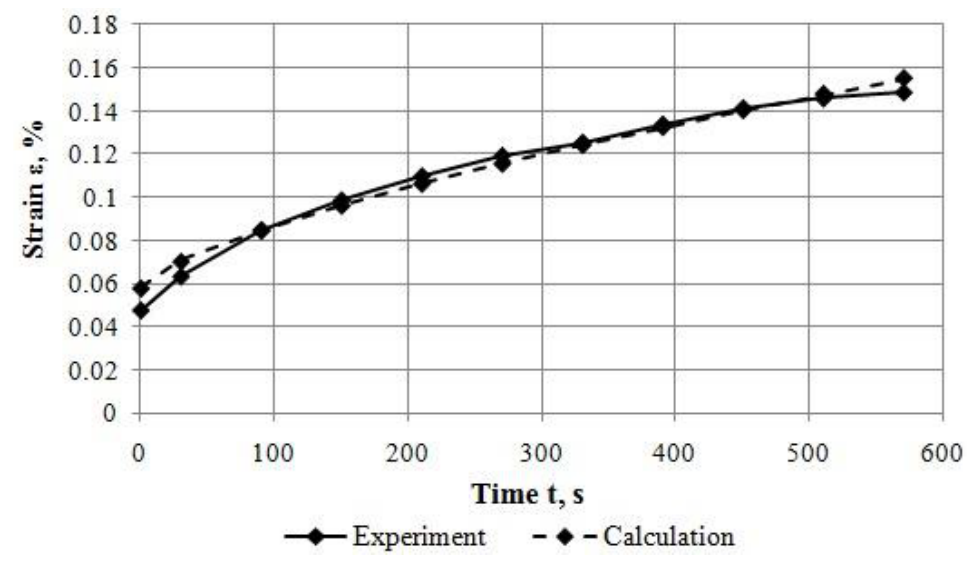
Figure 9. Graphs of experimental rheological parameter of the asphalt concrete at various stresses.